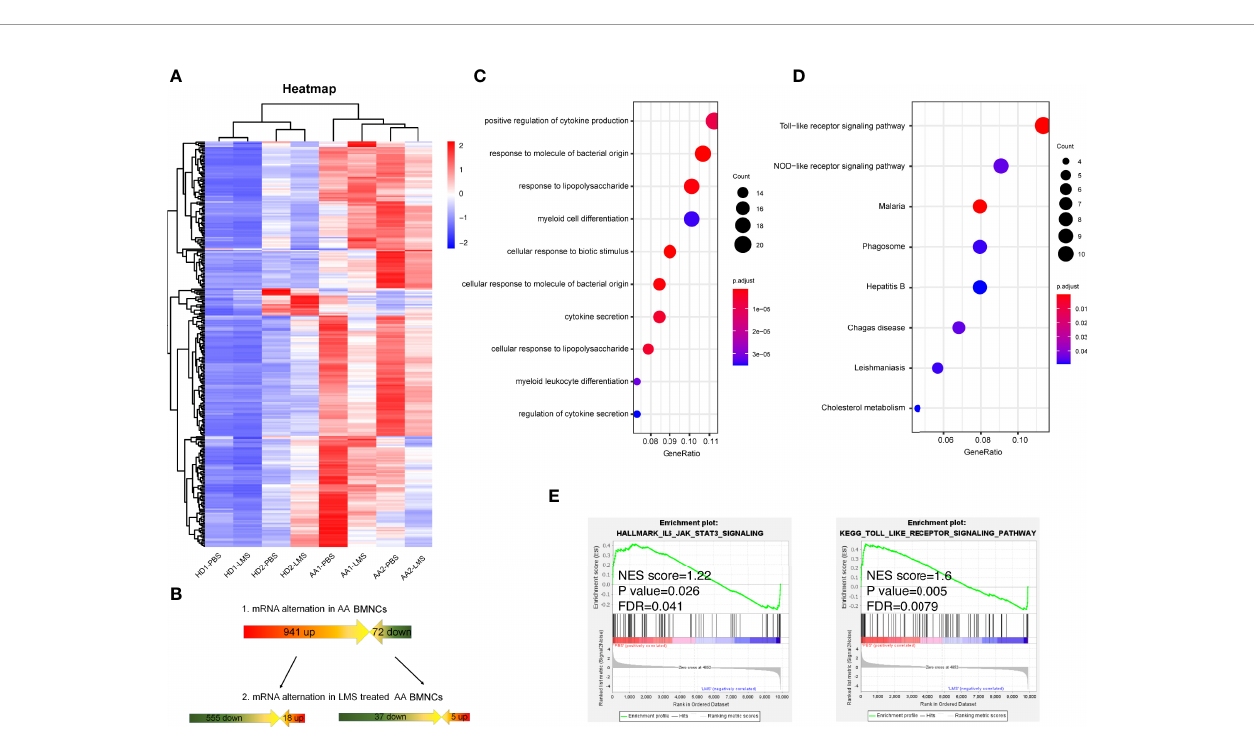
FIGURE 4 | RNA sequencing indicating LMS-induced changes in BMNCs from NSAA patients could alter multiple immune-related functions and signaling pathways. (A, B) BMNCs from healthy donors or NSAA patients were separated and treated with PBS or 40 m g/ml LMS. After co-culturing in vitro for 48 h, total RNA was extracted and the RNA sequencing was carried out. Gene transcripts with higher expression in NSAA and lower levels after LMS treatment were selected and analyzed. Dot graph showed GO pathways (C) and KEGG pathways (D) downregulated in patients with NSAA treated with LMS compared with those treated with PBS in vitro . (E) Gene pathways that were differentially expressed in NSAA patients with or without LMS according to GSEA (right side was post-treated sample by LMS). Gene sets were considered statistically signi fi cant at NES<1, FDR<0.05 and p value